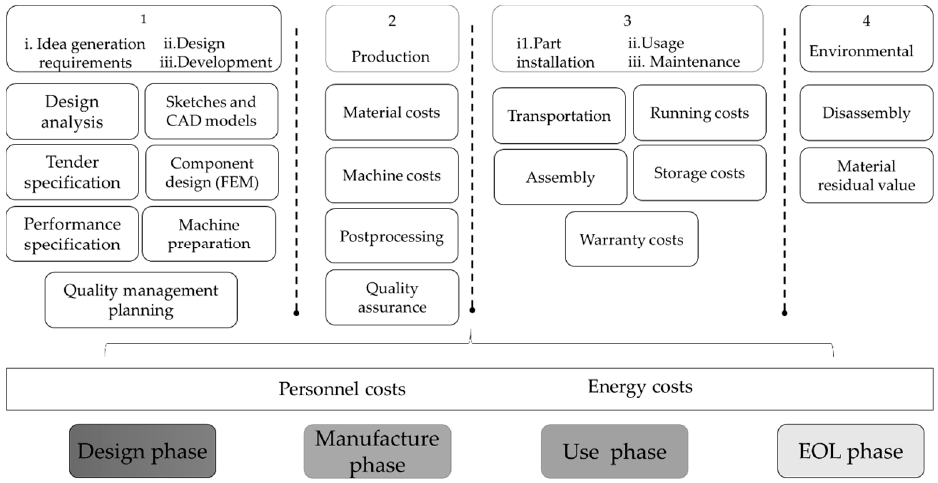
Figure 5. Schematic of the LCC model in the study of Lindemann et al. (2013). Adapted from [29].